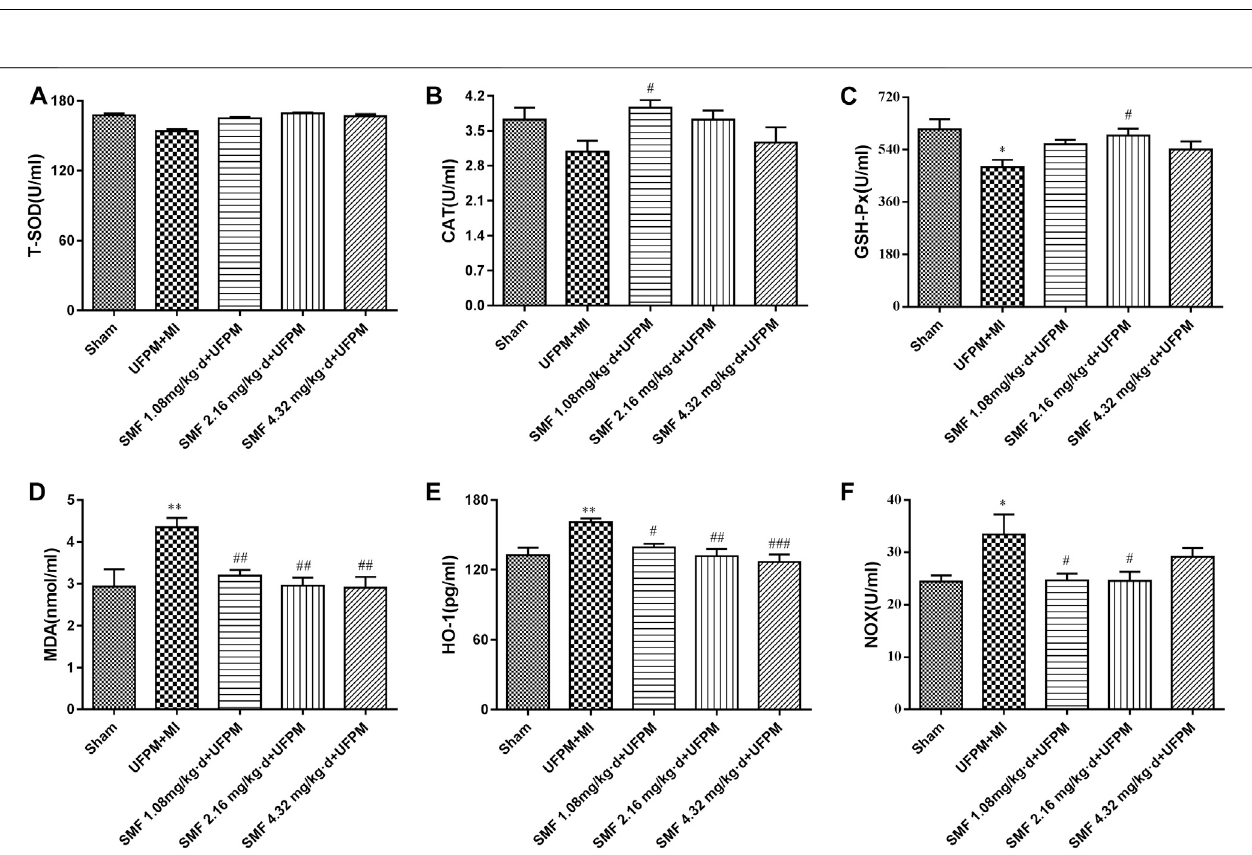
FIGURE 3 | Effects of SMF on UFPM-induced oxidative stress in rats with MI. (A) T-SOD (total superoxide dismutase), (B) CAT (catalase), and (C) glutathione peroxidase (GSH-Px) activity were measured in serum from the fi ve experimental groups. (D) Malondialdehyde (MDA), (E) Heme oxygenase-1 (HO-1), and (F) NADPH oxidase (NOX) were analyzed. Data are represented as mean ± SEM. * and **, signi fi cant difference from sham group at p < 0.05 and p < 0.01; #, ## and ### , signi fi cant differences from the UFPM group at p < 0.05, p < 0.01, and p < 0.001, respectively. MI, myocardial ischemia; SMF, Shengmai formula; UFPM, ultra fi ne particulate